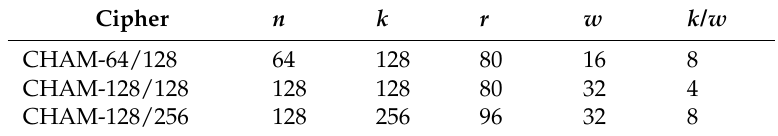
Table 1. Parameters of CHAM family ( n : Block size, k : Key size, r : Round number, and w : Word